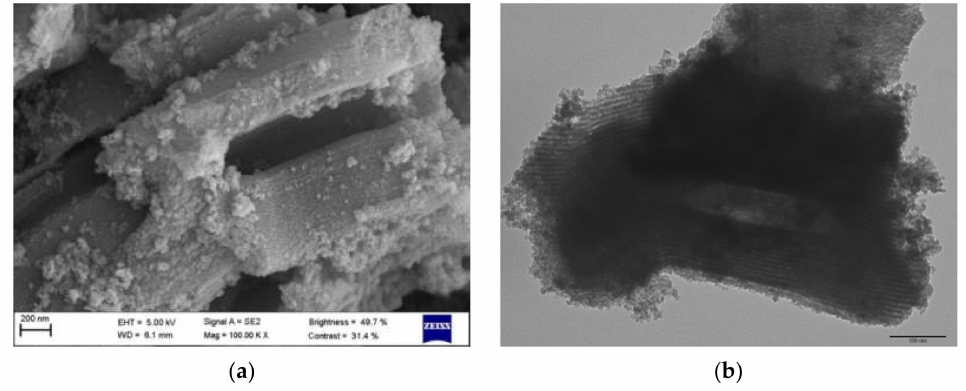
Figure 1. ( a ) SEM and ( b ) TEM micrographs of Fe 3 O 4 @PAA/SBA15. Scale bar on the TEM image corresponds to 100